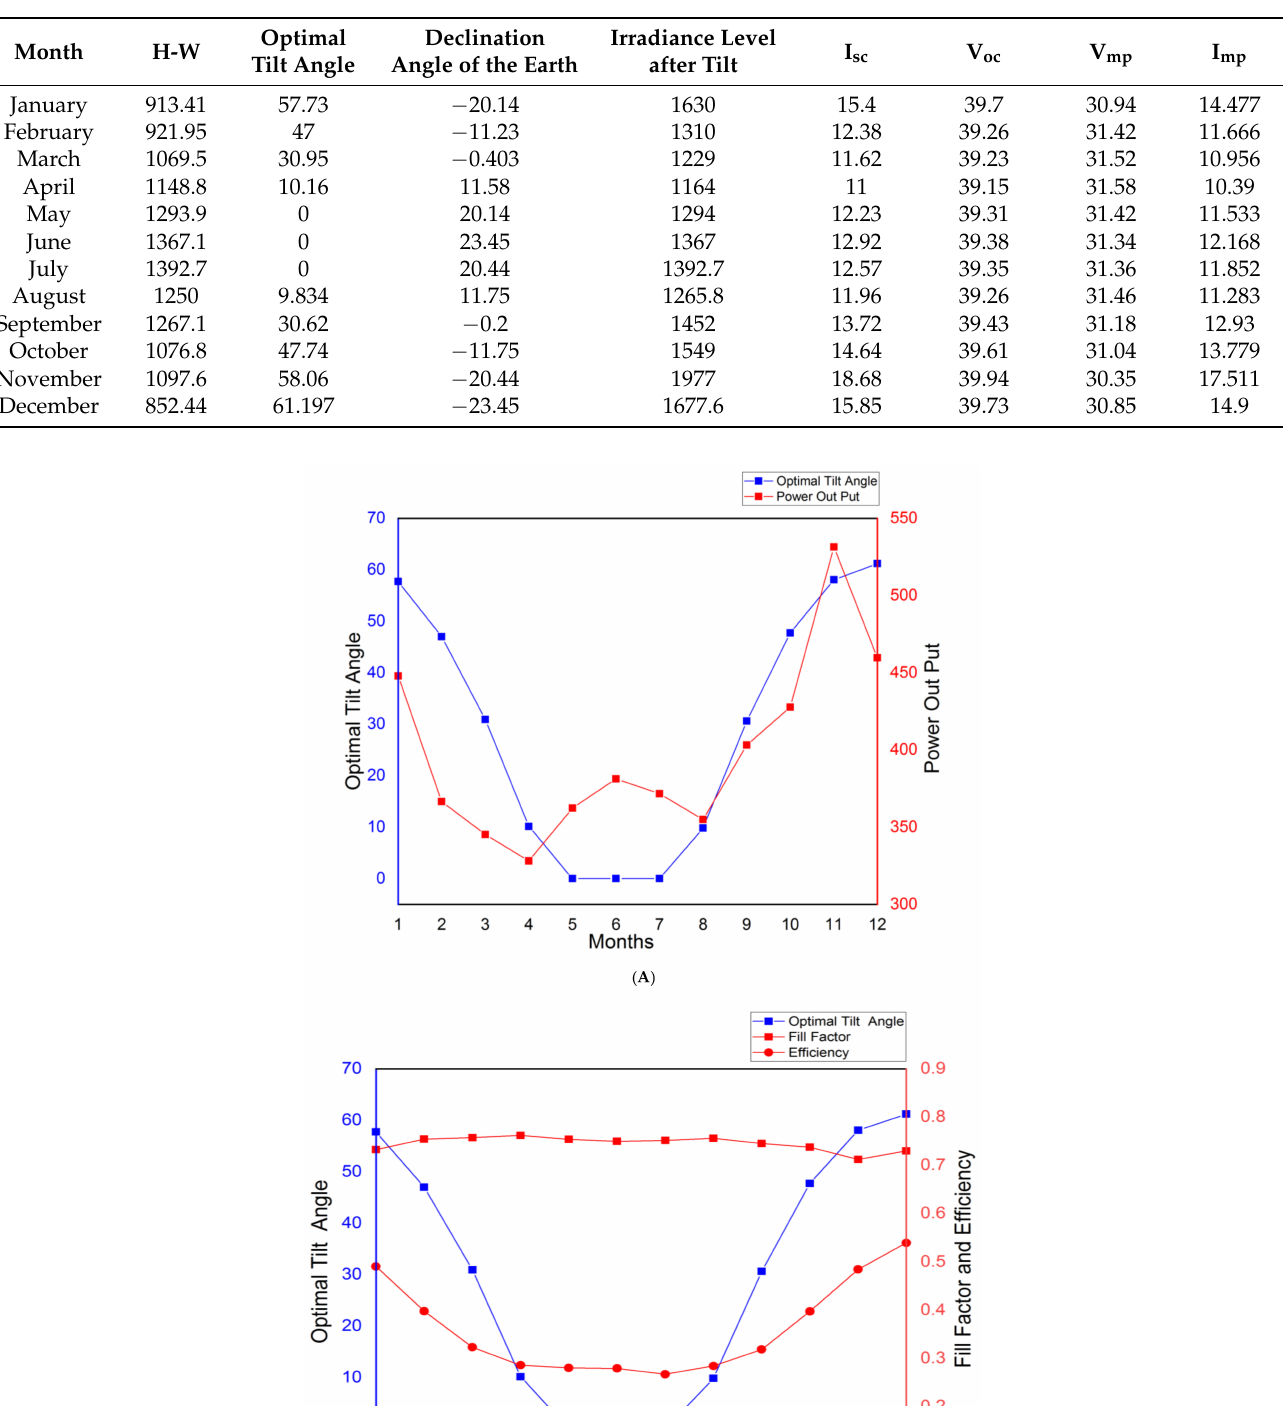
Table 6. Monthly specific daily global irradiance (H), optimal tilt angle (deg), declination angle of the